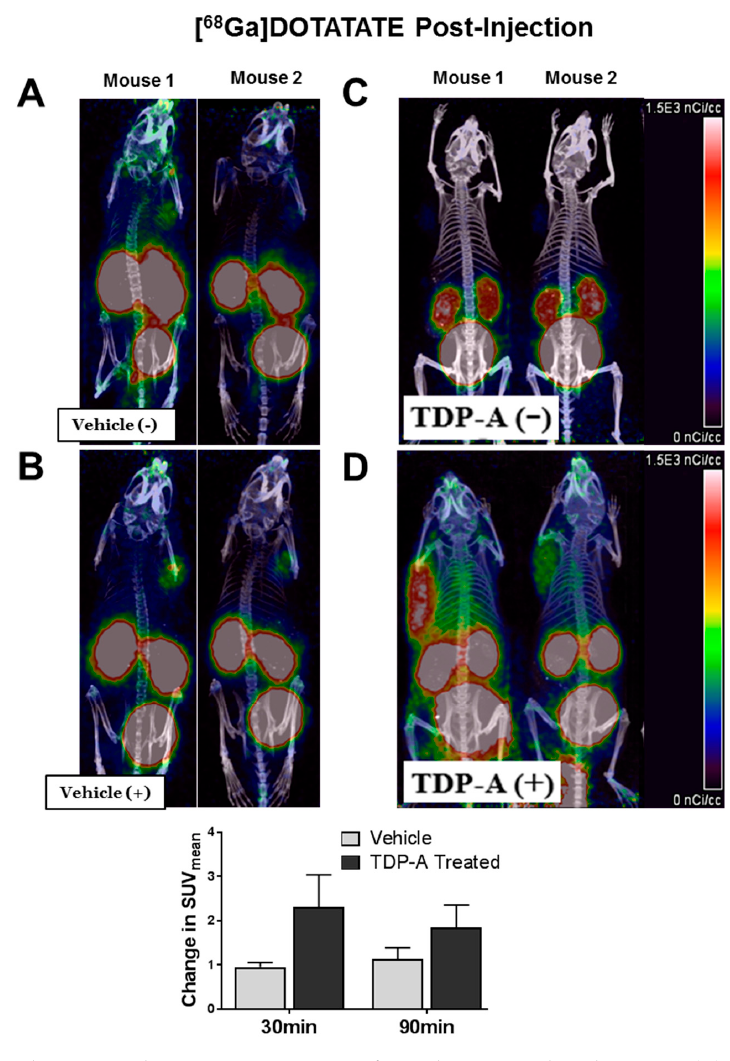
Figure 6. Mice bearing pulmonary NET xenografts and pretreated with TDP-A ( + ) demonstrated